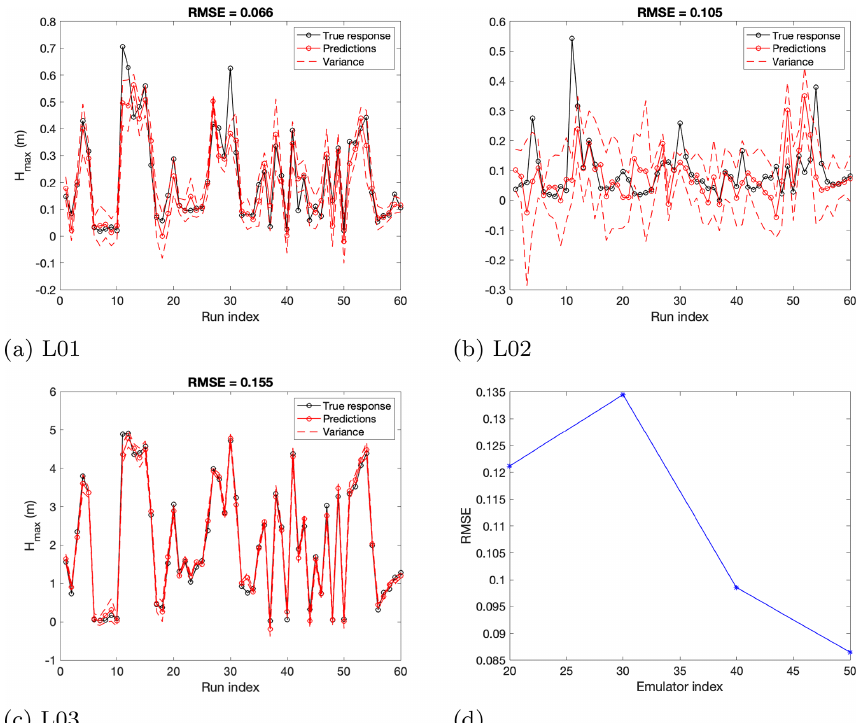
Figure 9. (a–c) LOO diagnostics for points close to ( a : location L01) and far from ( b : location L02) the design location and large fluctuations in the results ( c : location L03) (locations 01, 02 and 03 in Fig. 4). The RMSE yields values that vary from 0.066 to 0.105 for locations 01 and 02 and 0.145 in location 03. (d) Error estimation for the predictions of the last 10 runs at location 01.